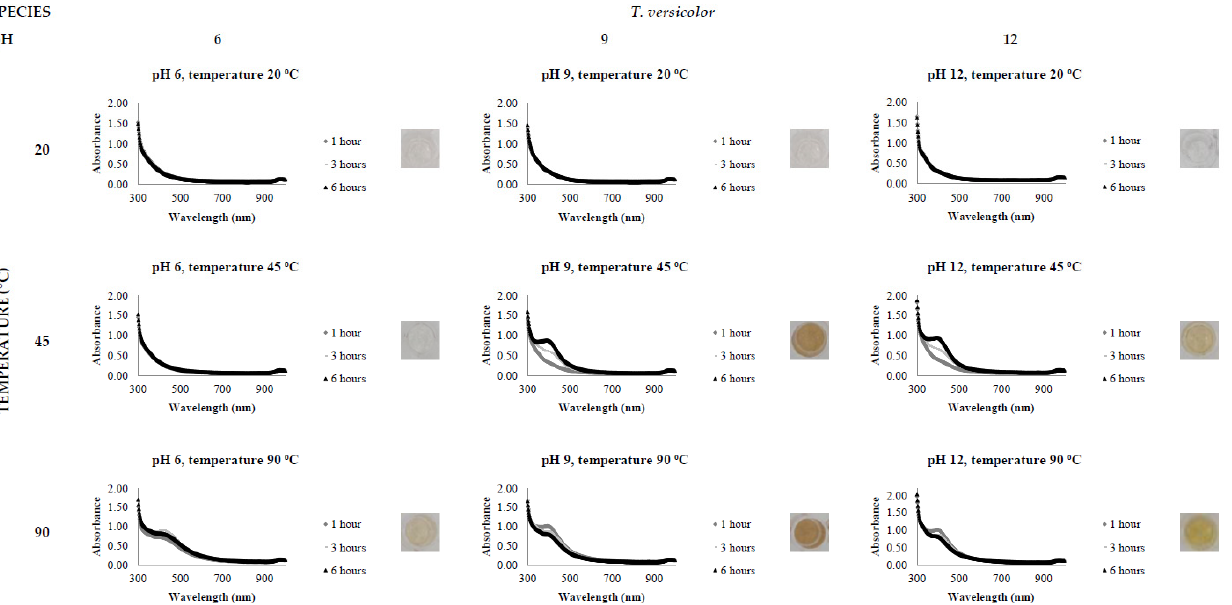
Figure 3. LSPR spectra of P. antarcticum cell-free extract in the synthesis of AgNPs, by the addition of 0.5 mM AgNO 3 , varying the reaction time (1, 3 and 6 h), temperature (20, 45 and 90 °C) and pH (6, 9 and 12), through UV-Vis spectrophotometry analysis.